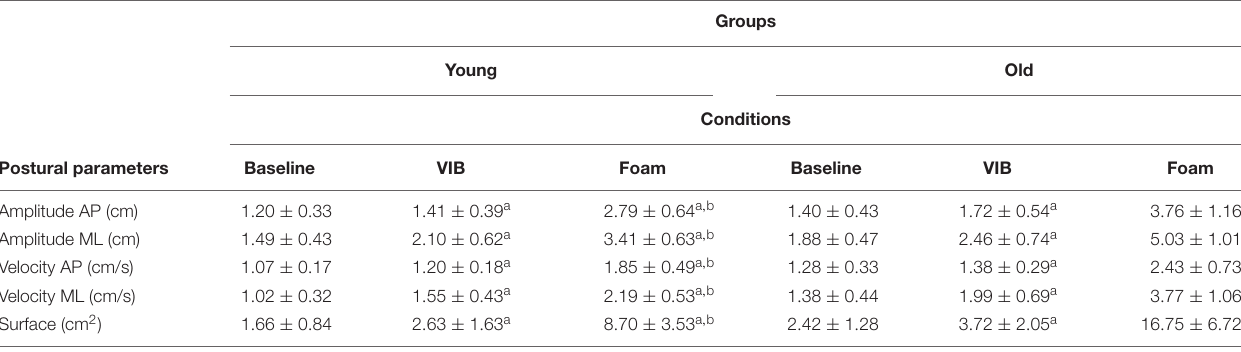
TABLE 2 | Postural parameters expressed in mean ± standard deviation for each group and experimental conditions. Groups Young Old